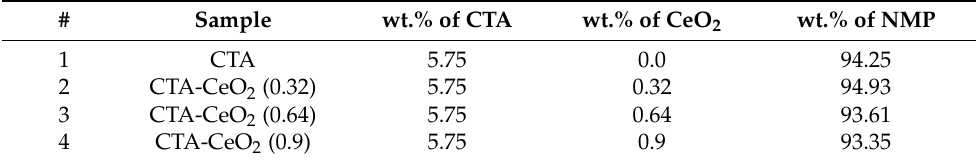
Table 1. Composition of polymer, nanoparticles and solvent used in MMM